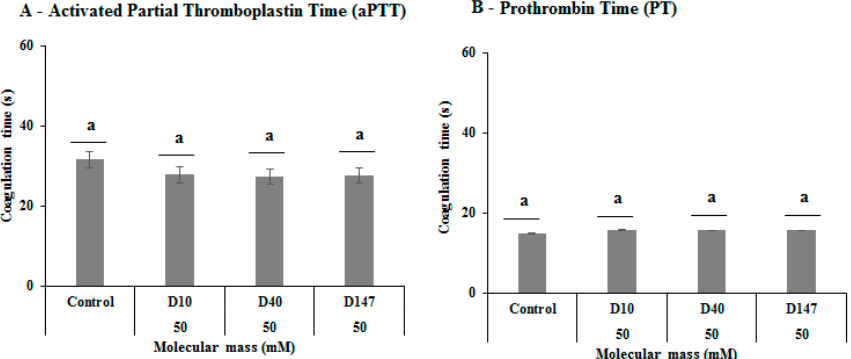
Figure 4. Anticoagulant activities of D1, D40 and D147: ( A ) activated partial thromboplastin time (aPTT); and ( B ) prothrombin time (PT). Letter a represent non-significant difference between the various samples according to the variation analyses (one-way ANOVA) followed by the Tukey–Kramer ( p < 0.05) test.